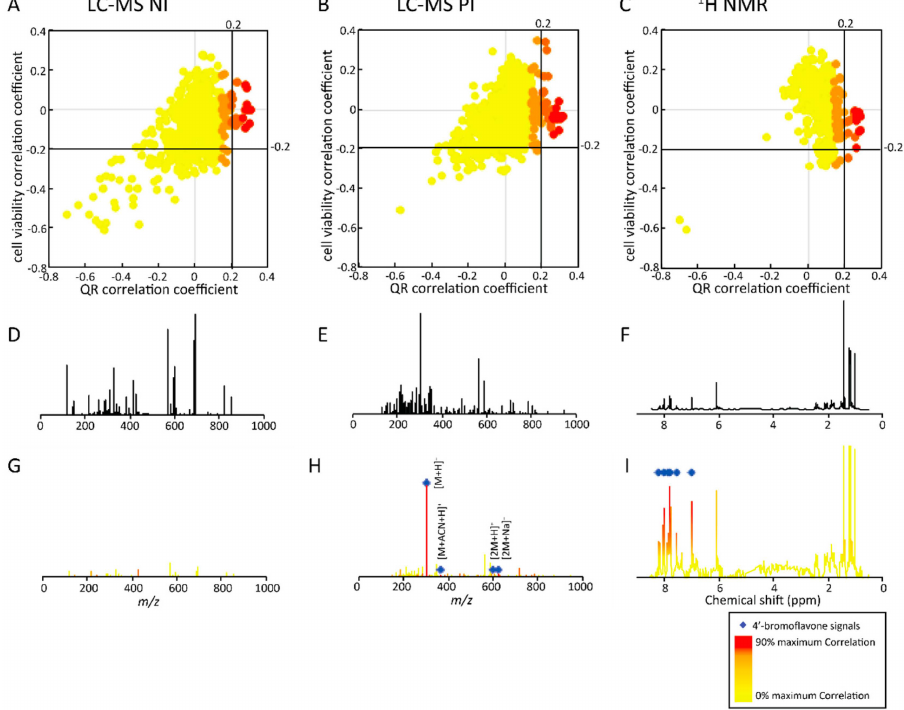
Figure 4. Correlation scatter plots between the two biological evaluations (x axis: QR induction—QR induction; y axis: cell viability) with features peak area in the different microfractions and the spectra corresponding to the active zone before and after activity filtering. Three untargeted approaches were evaluated using features detected by NI LC-MS ( A ); PI LC-MS ( B ) and 1 H-NMR profiling ( C ); Correlations were calculated using log- and logit-transformed values from QR induction and cell viability assays, respectively. The sum spectrum of the active zone (B10-G10) are represented for the three analytical techniques ( D – F ); Based on correlation values, QR induction active features are highlighted (correlation value > 0.2) in the NI ( G ); PI ( H ); 1 H-NMR ( I